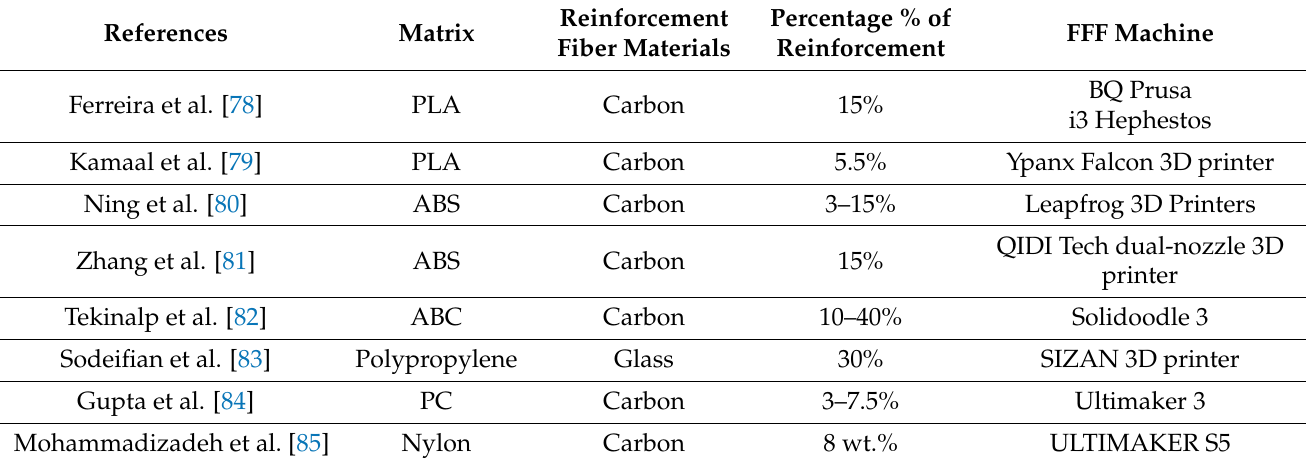
Table 5. Short fiber composites for filaments. ABS—acrylonitrile butadiene styrene, PLA—polylactic Acid,